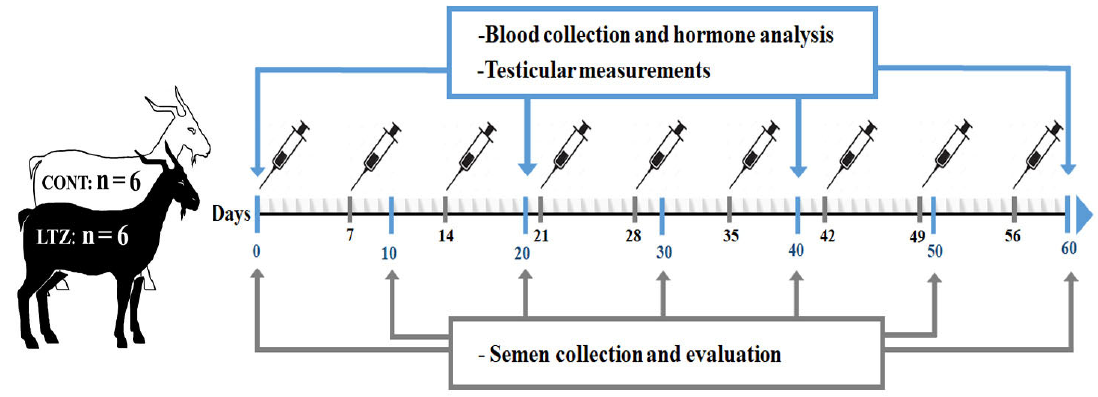
Figure 1. Diagrammatic representation of the experimental design, and sampling schedule in aged Markhoz bucks treated letrozole (LTZ) (0.25 mg/kg BW/wk) or control (CONT).